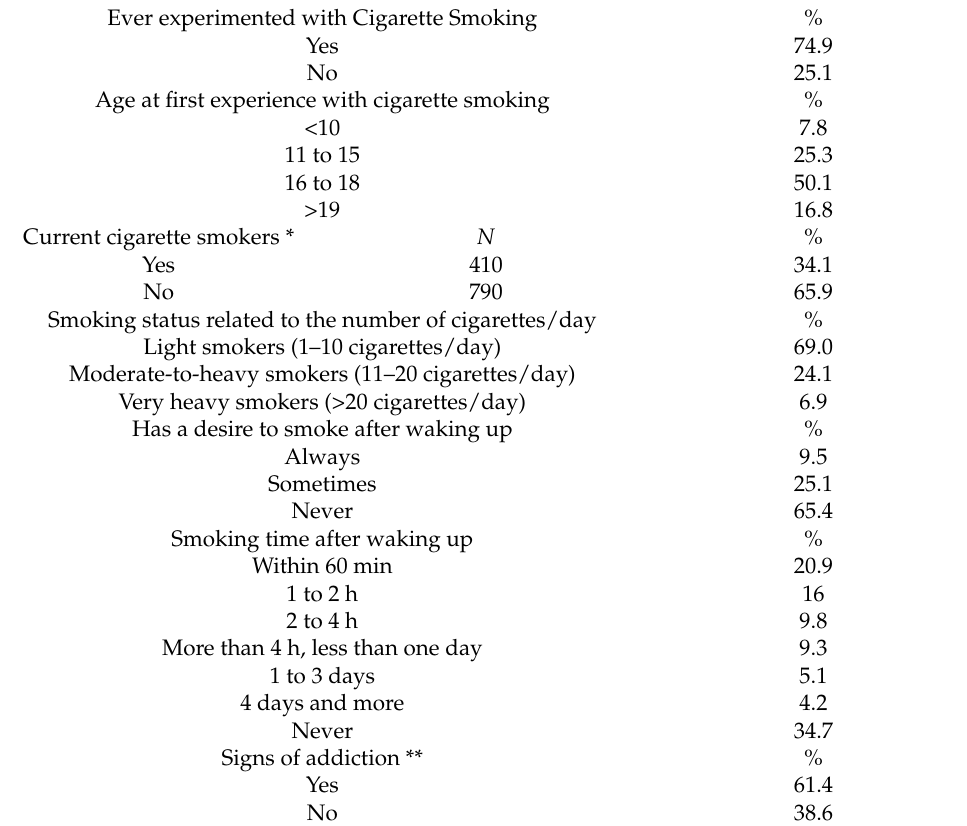
Table 2. Students’ cigarette smoking